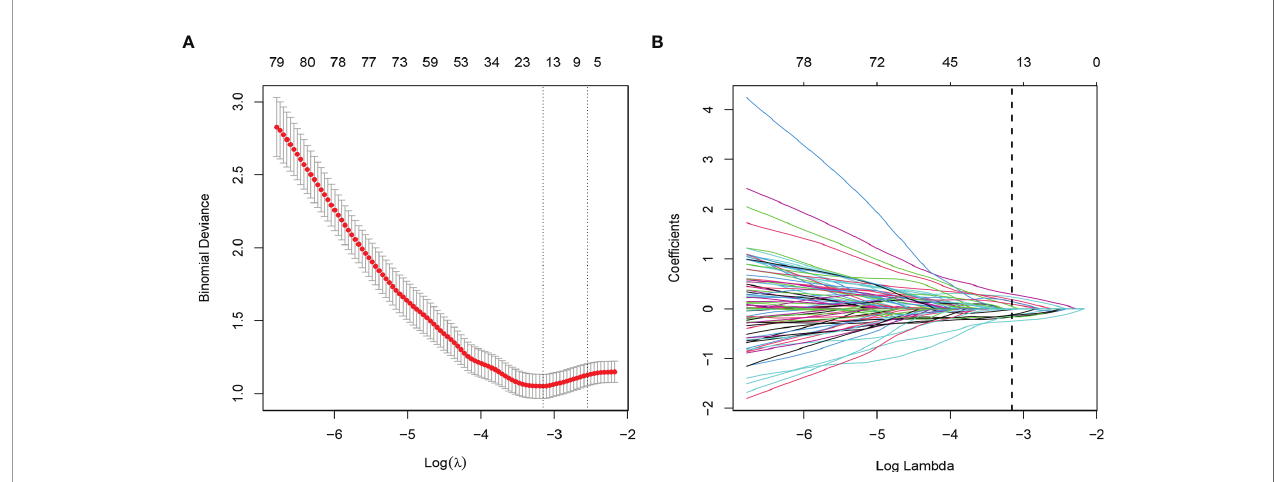
FIGURE 3 | Radiomic feature selection by using the least absolute shrinkage and selection operator (LASSO) logistic regression. (A) The selection of tuning parameter ( l ) in the LASSO model used 10-fold cross-validation via minimum criteria. The AUC curve was plotted versus log ( l ). (B) LASSO coef fi cient pro fi les of the radiomics features. A vertical line was plotted at the optimal l value, which resulted in 15 features with nonzero coef fi